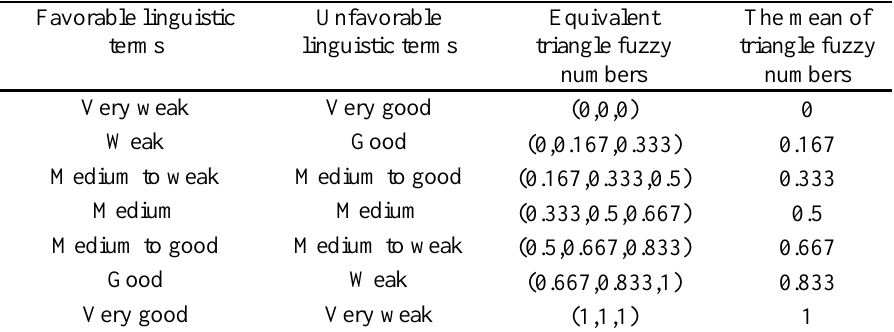
Table 3. Linguistic terms used in evaluating supplier’s